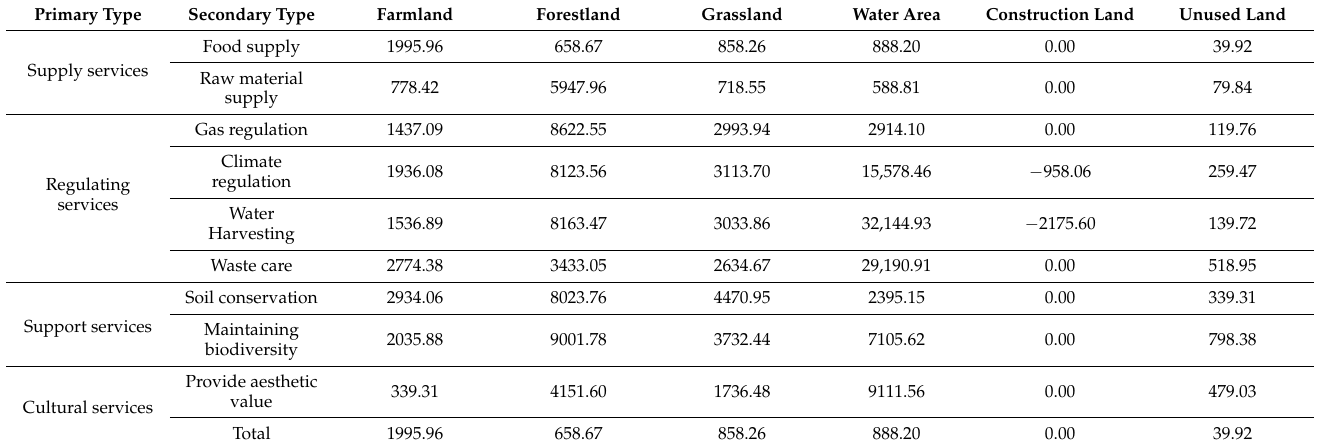
Table 1. The monetary equivalent of the ecological services that a unit area ecosystem